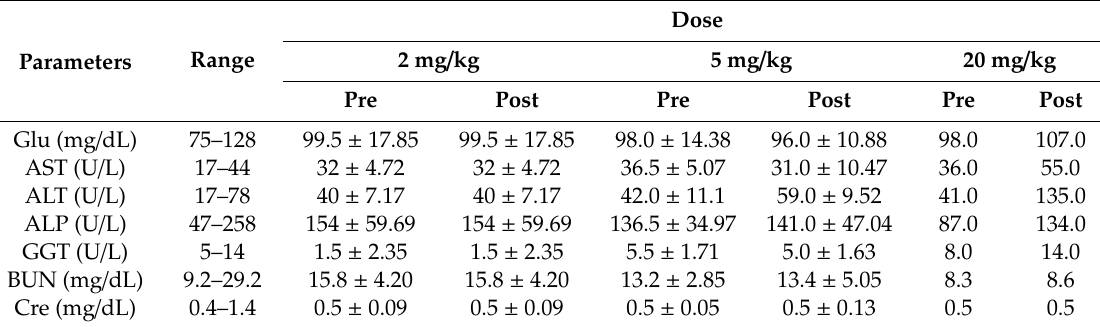
Blood analysis of dogs pre- and post-intravenous administration of three doses of glucose-conjugated chlorin